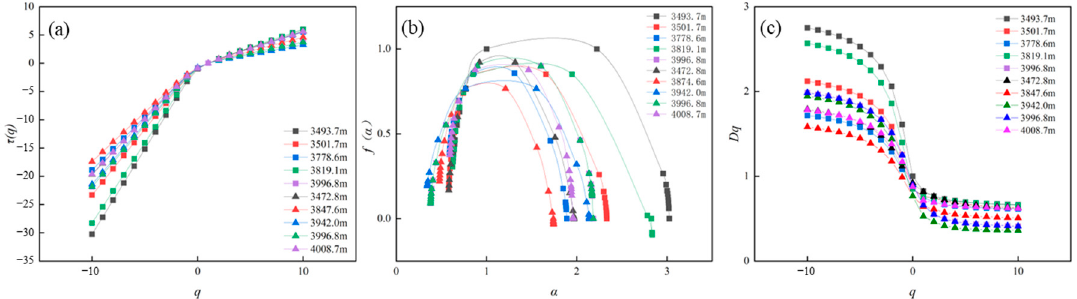
Figure 15. NMR logging multifractal parameter atlas: ( a ) Relationship between τ ( q ) and q . ( b ) Rela- tionship between f ( α ) and α ; ( c ) Relationship between D q and q .